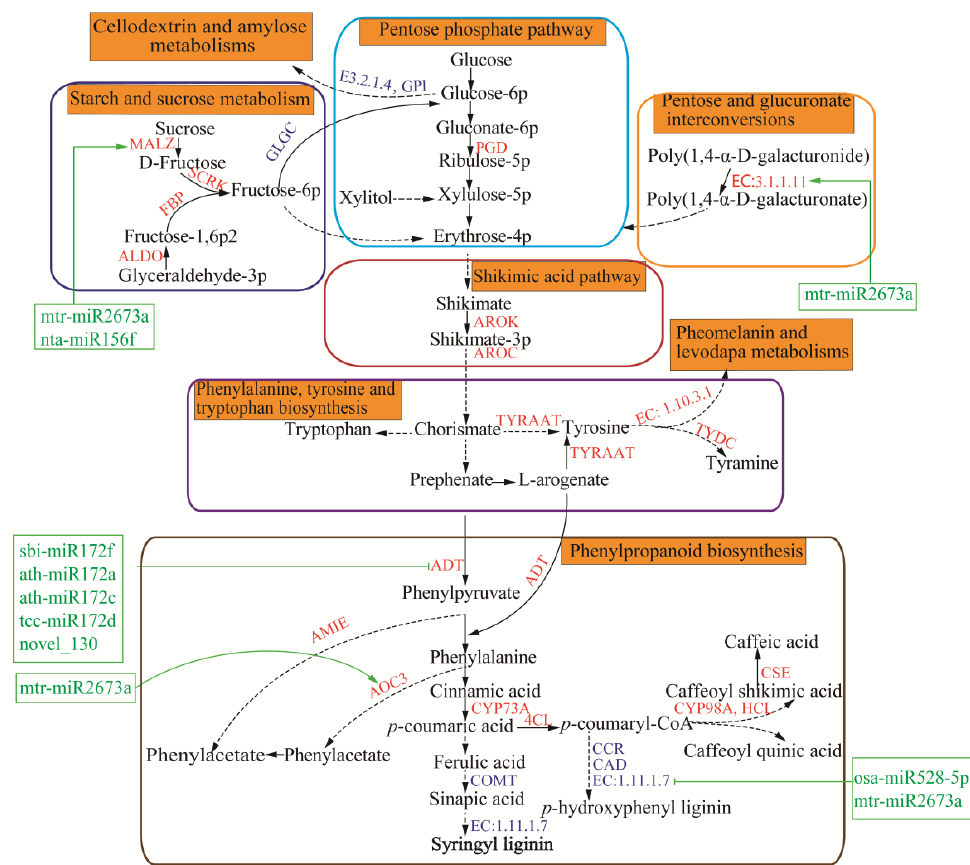
Figure 6. Regulatory network of phenolic acid biosynthesis in the roots of P. odoratum . The red letters are up-regulation genes, the blue letters are down-regulation genes, and the green letters are miRNAs. An arrow with a solid frame indicates only one step, while an arrow with a dotted frame arrow indicates more than one step. Black arrows indicate directions for the biosynthesis of phenolic acid.